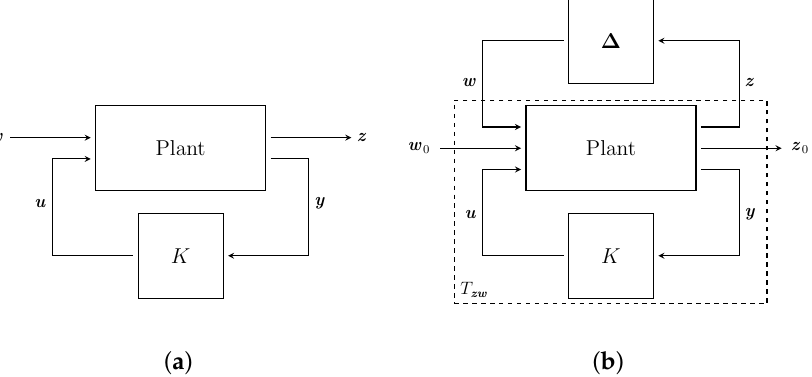
Figure 1. ( a ) A plant without model uncertainty, where w is a vector signal containing external noise, disturbances, and the reference signal. The system output is given in z . Measurements are represented by y , while u is the control signal. ( b ) A plant with all possible model uncertainty expressed as ∆ . Here w 0 depicts external noise, disturbances, and the reference signal. Now w is a signal representing parameter perturbations and model uncertainty. The system output is again described with z 0 and z . Measurement and control signals are given by y and u , respectively. Both plants are stabilized by a controller K